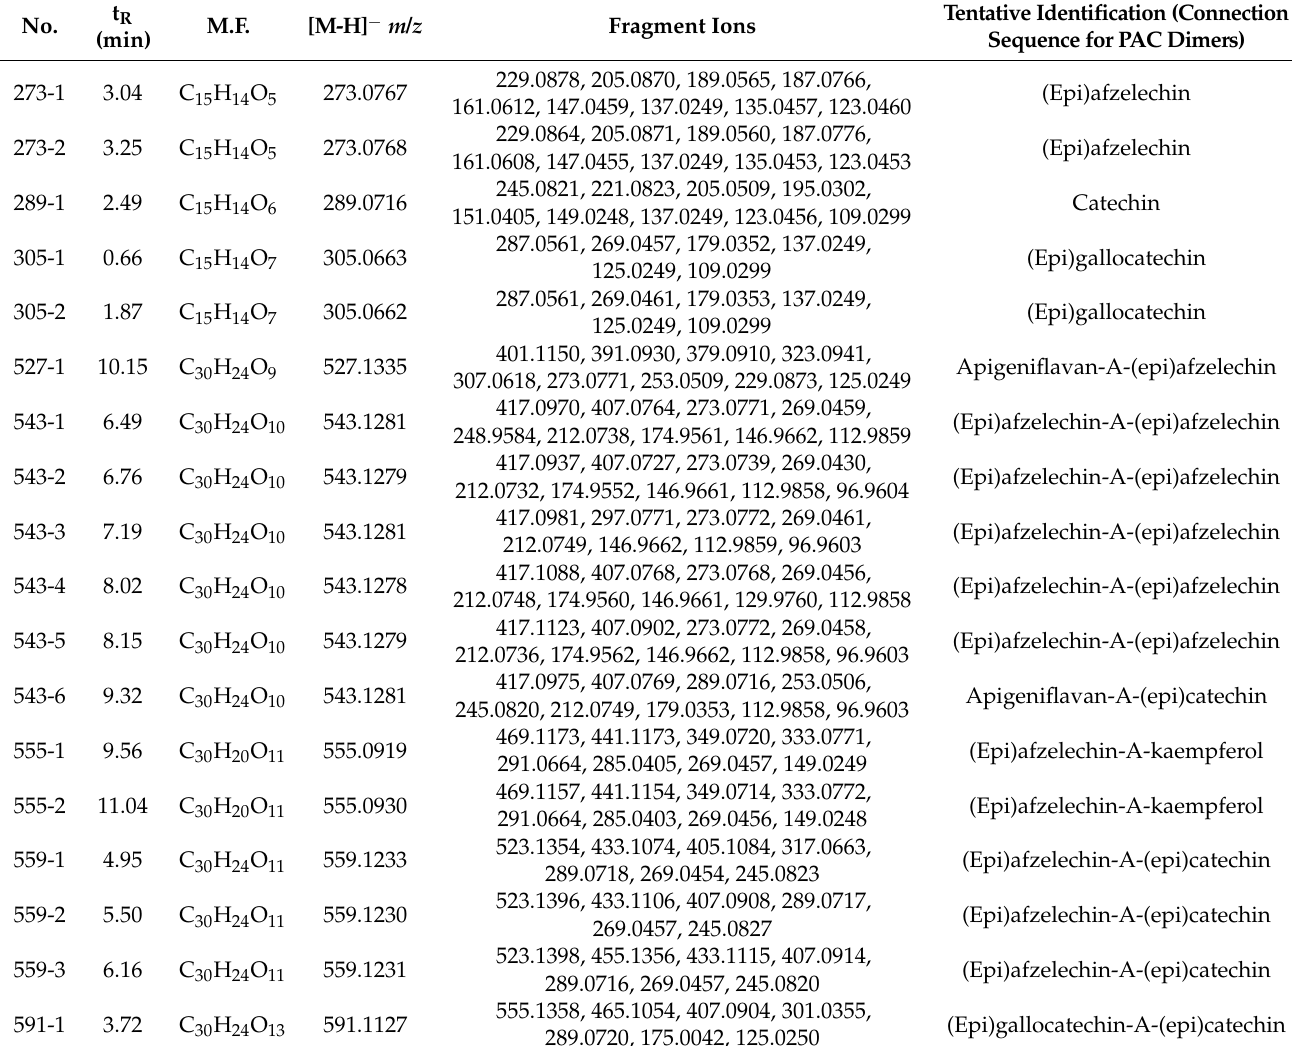
Table 1. The tentative identification of chemical compounds in the